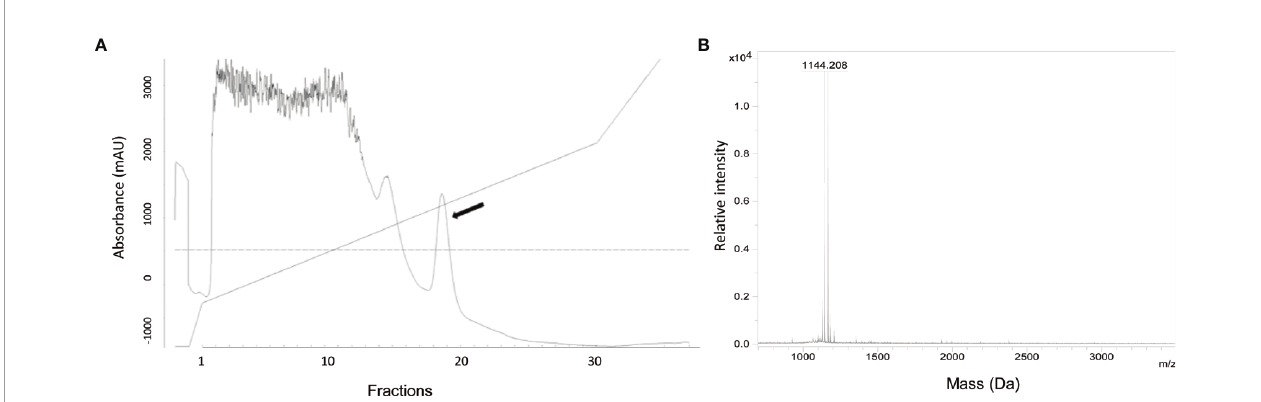
FIGURE 1 | (A) RPC elution pro fi le of MP1 from the cell-free supernatant of S. equorum KAVA. MP1 elution peak indicated with an arrow. (B) Mass spectrometry analysis of the active fraction of MP1 after the RPC. The inset is ampli fi cation of the MP1 peak